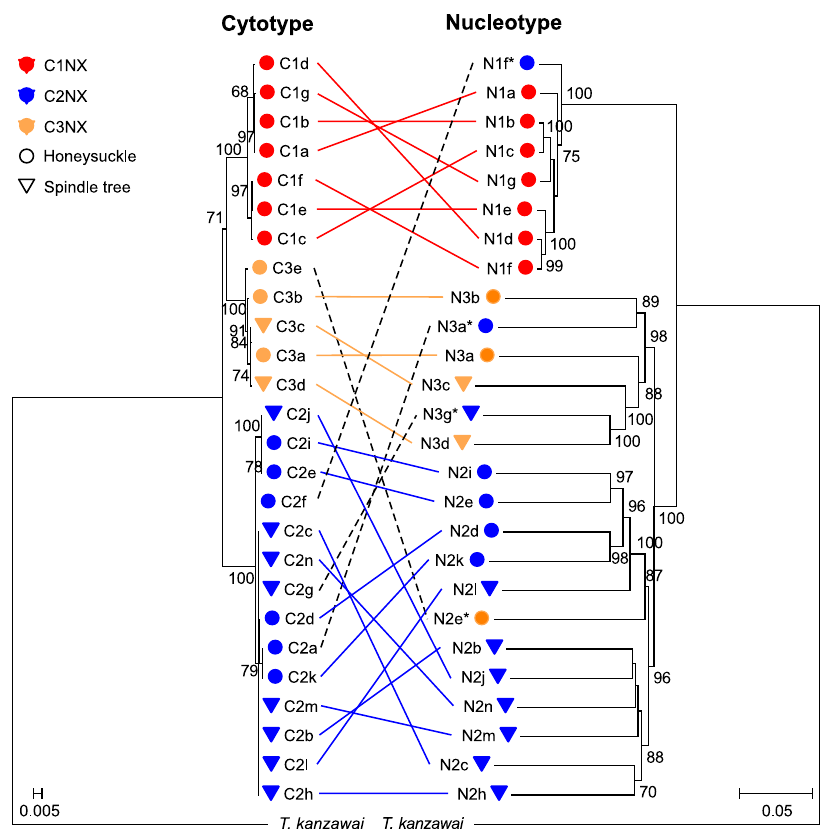
Fig. 2 Mitochondrial and nuclear genome phylogenies of fi eld-derived Tetranychus urticae iso-female lines. At left is a maximum likelihood analysis based on the optimal partitioning scheme of 13 protein-coding mitochondrial genes. At right is a neighbour-joining analysis using whole nuclear genomes. In both analyses, Tetranychus kanzawai is included as an outgroup. The scale bar of the mitochondrial phylogeny represents the nucleotide substitutions per site, the scale bar of the nuclear genome phylogeny represents substitutions per nuclear SNP position. Mitochondrial and nuclear phylogenies for the same fi eld-derived lines are labelled and connected by lines, with colours according to their cytotype and shapes according to their native hosts. Cyto-nuclear hybrids are connected with dotted black lines and have asterisks next to their nuclear name. Only bootstraps values ≥ 65 are